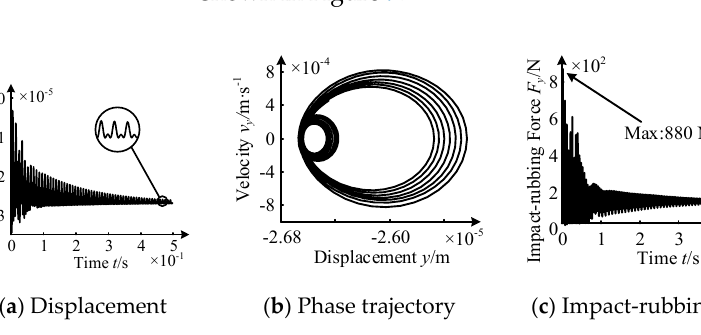
Figure 9. Operating law under upper unit failure. According to Figure 9, the bouncing stage mainly occurs within 0.07 s. The rotor displacement, impact-rubbing force, and residual electromagnetic force shake violently, and their amplitudes gradually decrease. The maximum impact-rubbing force is 880 N. The eddy stage mainly occurs after 0.07 s. The displacement gradually converges at about − 26 μ m, which is larger than the unilateral air gap, indicating that the rotor will eventually stagnate at the bottom of the fixed ring. The phase trajectory presents a double- periodic closed circle from the outside to the inside, which indicates the displacement tends to converge. The variation of the impact-rubbing force/electromagnetic force is similar to that of the displacement, respectively, converging at about 125 N and − 25 N, and their vector sums are just in balance with the rotor’s gravity. 2. Impact-rubbing behavior under upper and lower unit failure The axis trajectory of the rotor under upper and lower unit failure mode is shown in Figure 10.